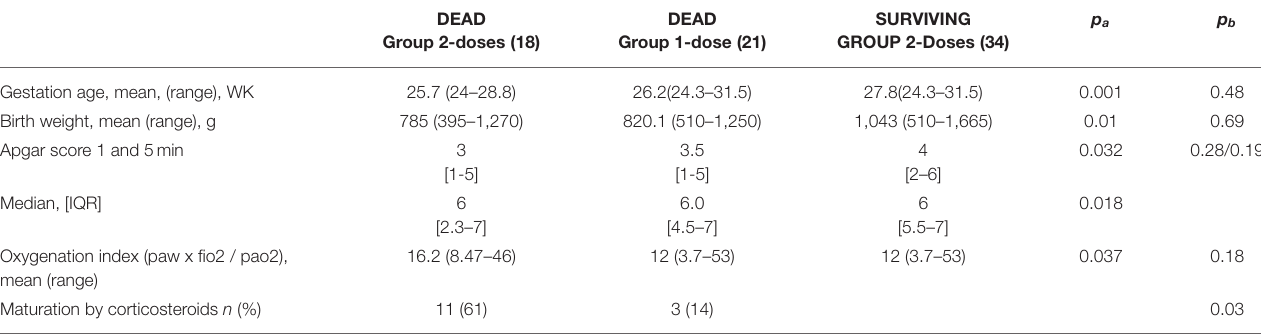
TABLE 5 | Perinatal characteristics of neonates comparing the dead and the living preterms in the group who received two doses of surfactant and comparing the dead in the two